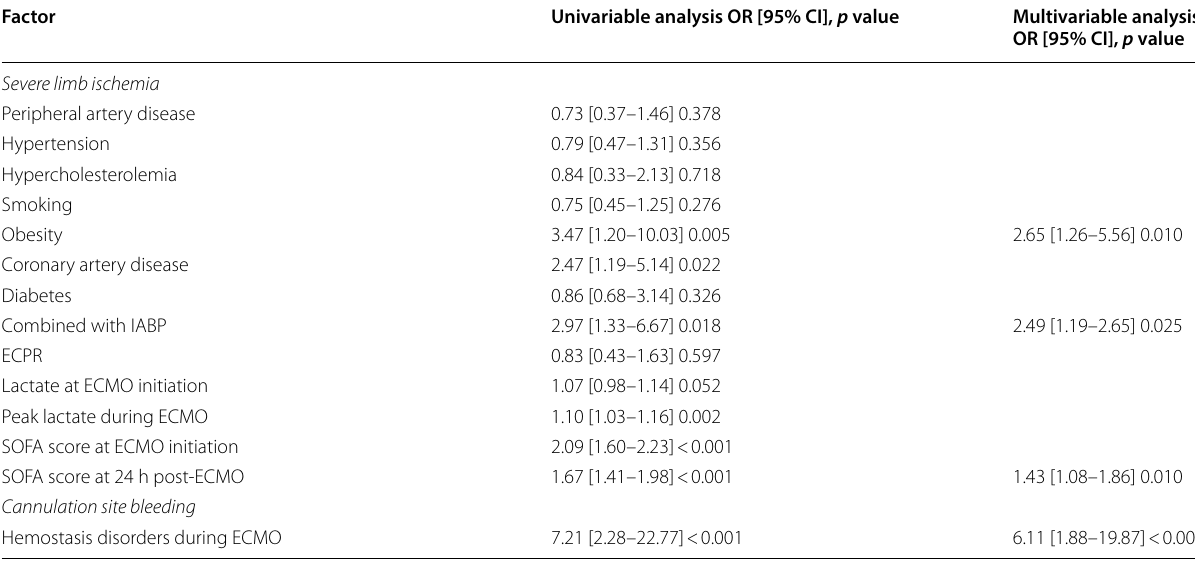
Table 3 Univariable and multivariable analyses of factors associated with major vascular complications (severe limb ischemia and cannulation site bleeding)